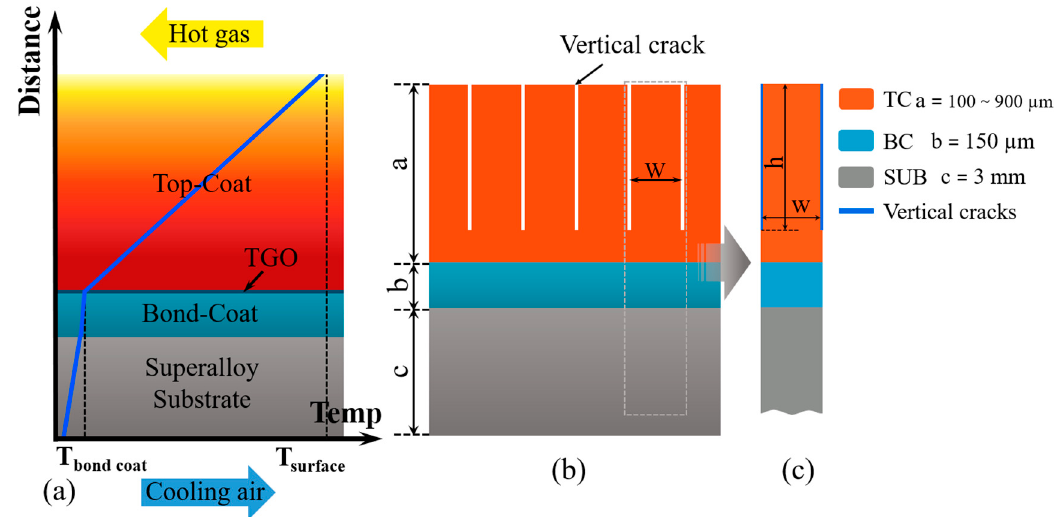
Figure 1. Schematic diagram of model structure: ( a ) TBC service environment during thermal expo-sure, ( b ) developed model structure of a TBC used for simulation, ( c ) crack periodic element of the physical geometry model.